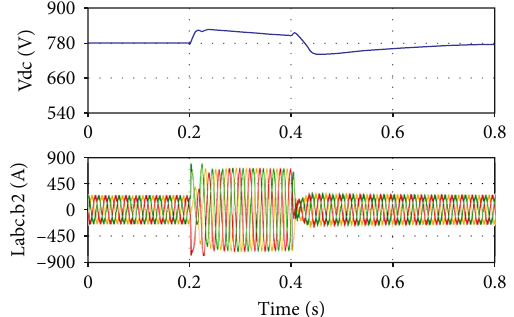
Figure 13: DC-link voltage and inverter currents during an AC bus fault.